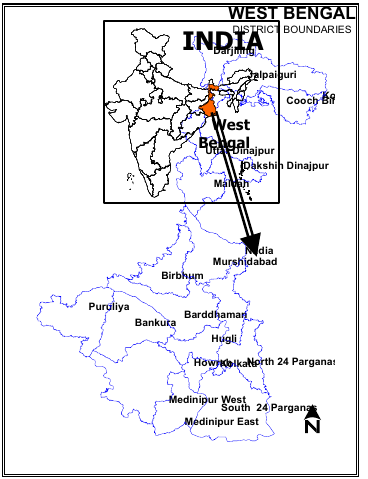
Fig. 1: Location map of West Bengal state